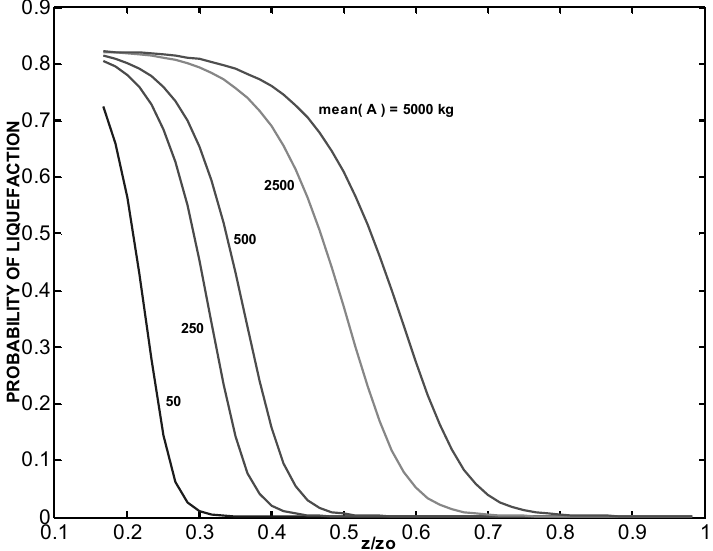
Fig. 4. Variation of the probability of liquefaction with the normalized depth (for several values of the mean load magnitude).